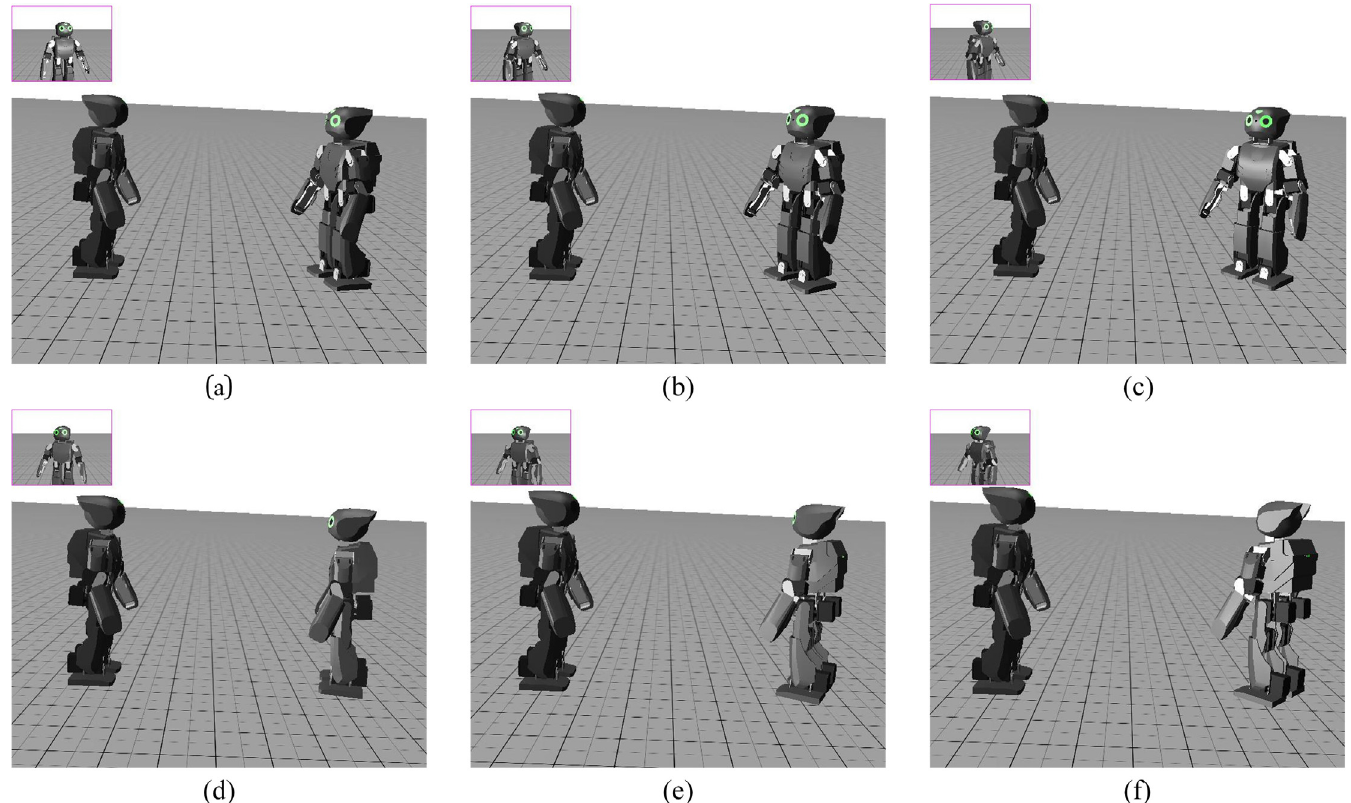
Fig 8. Example of different types of perspectives. (a) v1, (b) v2, (c) v3, (d) v4, (e) v5, (f) v6.